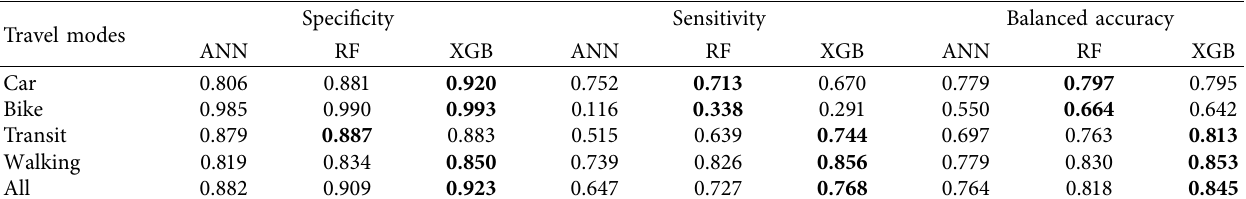
Table 3: Comparison of prediction performances of the ML